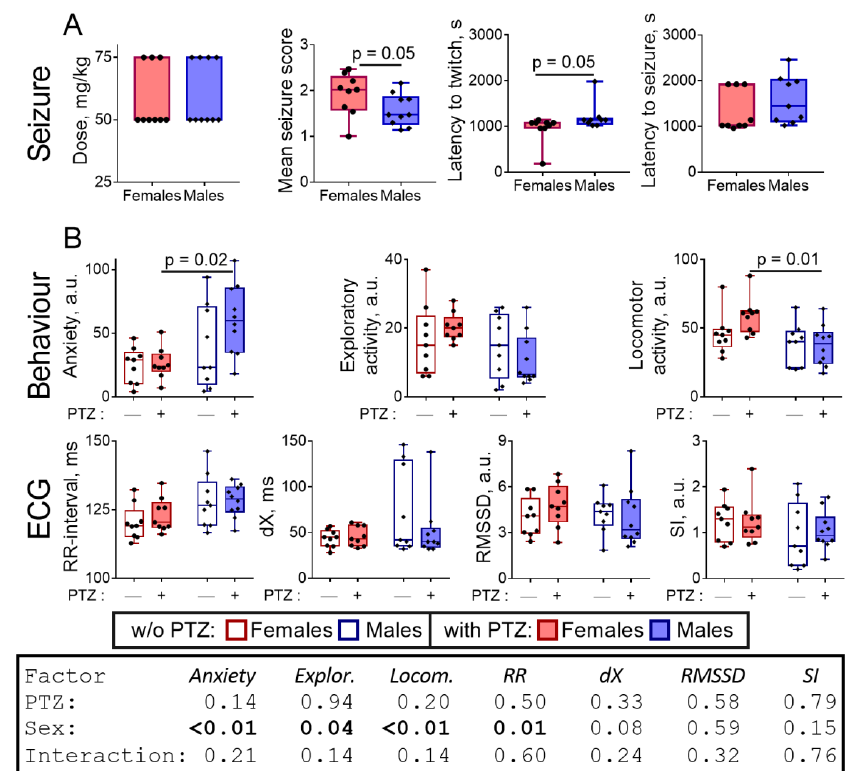
Figure 1. Sex-dependent parameters of the PTZ-induced seizure ( A ) and its delayed physiological effects ( B ) compared to the control animals. The assayed parameters are indicated on the Y axes. ( A )—“Dose” refers to the total PTZ dose received by an animal for the seizure induction; “Mean seizure score” is determined during the 45 min of the observation; “Latency to twitch” defines the time to the first myoclonic twitch (three points by the modified Racine scale, see “Materials and methods”); “Latency to seizure” defines the time to the first tonic seizure (four points by the Racine scale, see “Materials and methods”). ( B ) — Behavioral and ECG parameters of the rats the next day after a seizure compared to the control groups. The parameters of anxiety, exploratory activity and locomotor activity are obtained from the “open field” test as described in “Materials and methods”.